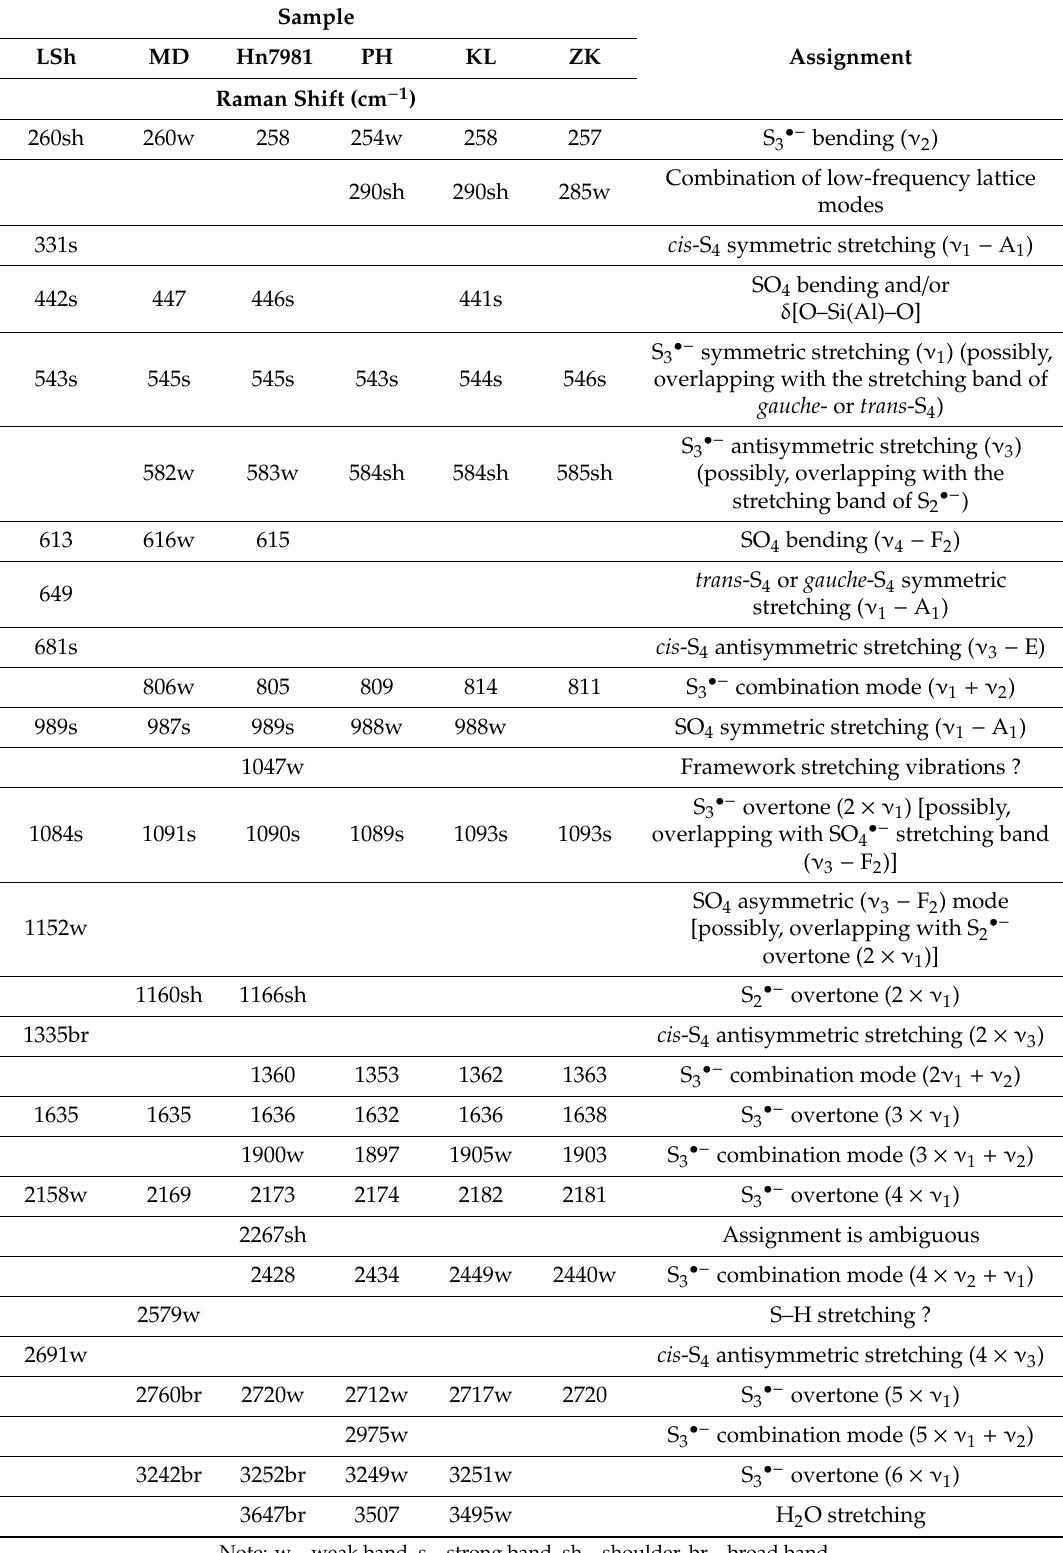
Table 2. Raman bands of sodalite-group minerals and their assignment.